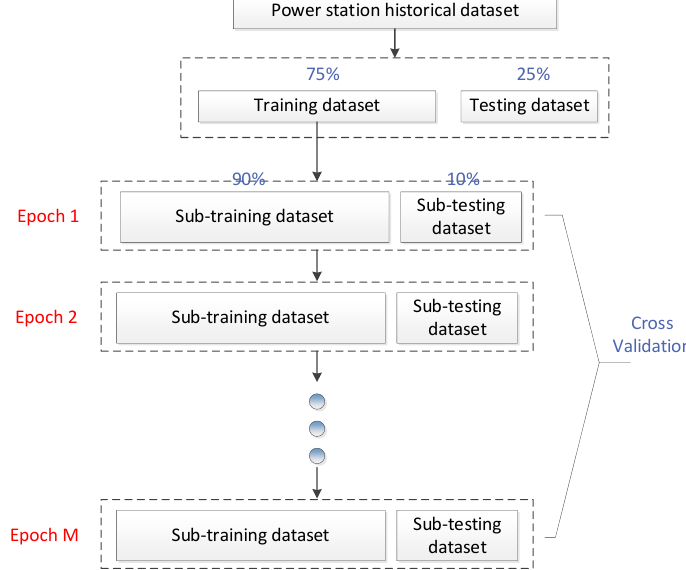
Figure 5. Division of the dataset.